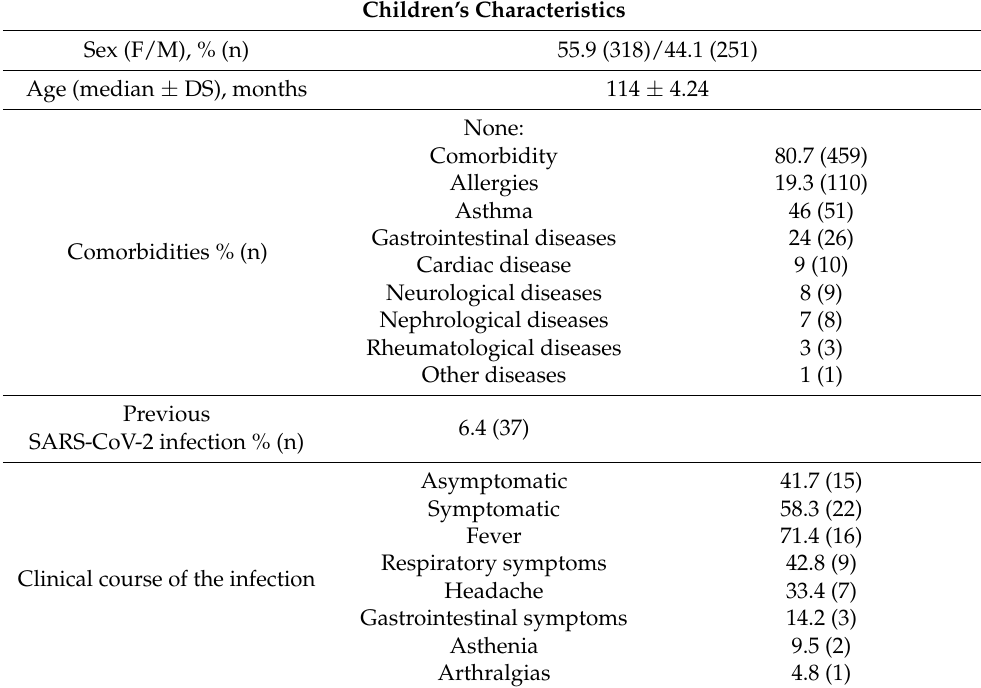
Table 1. Children’s clinical and demographic